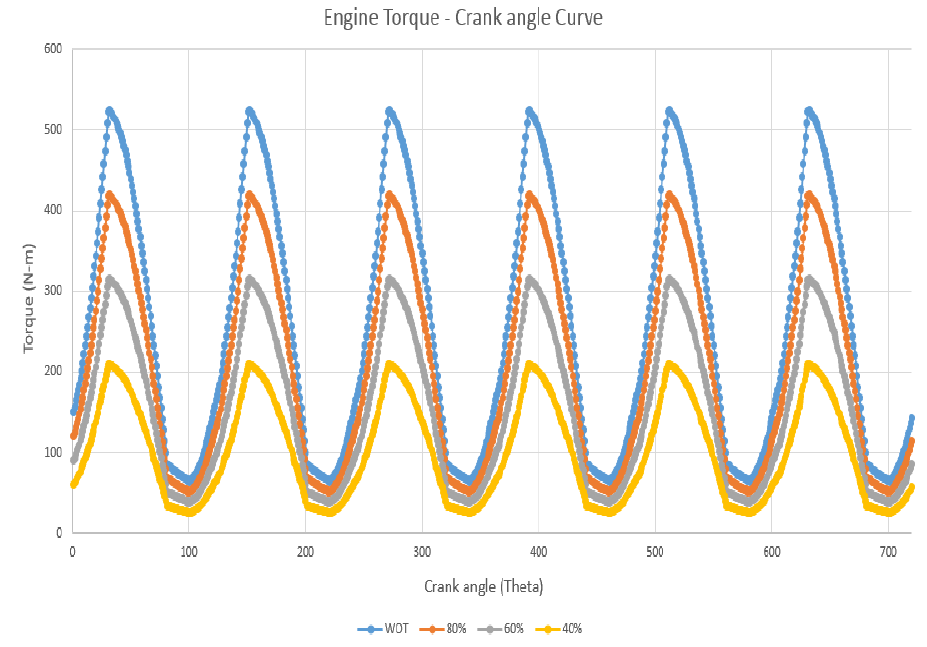
Figure 3. Output torque of internal combustion engine with ignition.